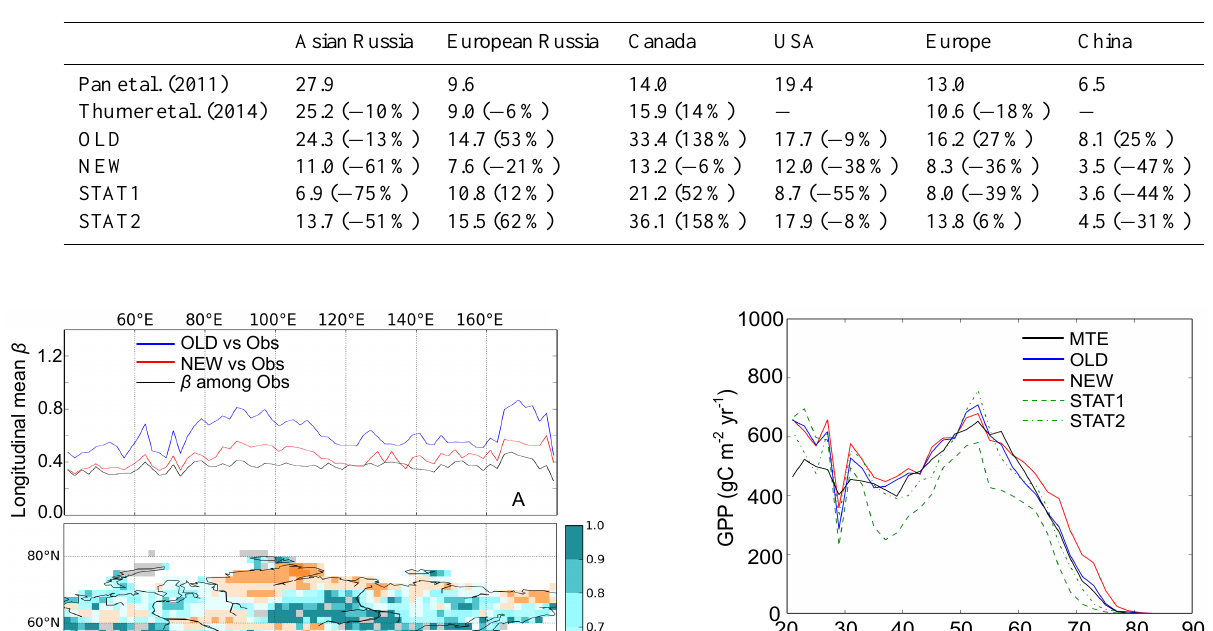
Table 5. Forest biomass (Pg C) for different countries/regions simulated by models (OLD, NEW and two static runs) and estimated from Thurner et al. (2014), in comparison with that from Pan et al. (2011). STAT1 and STAT2 prescribe different PFT maps, ESA and SYNMAP. The relative differences compared to Pan et al. (2011) are given in parentheses.